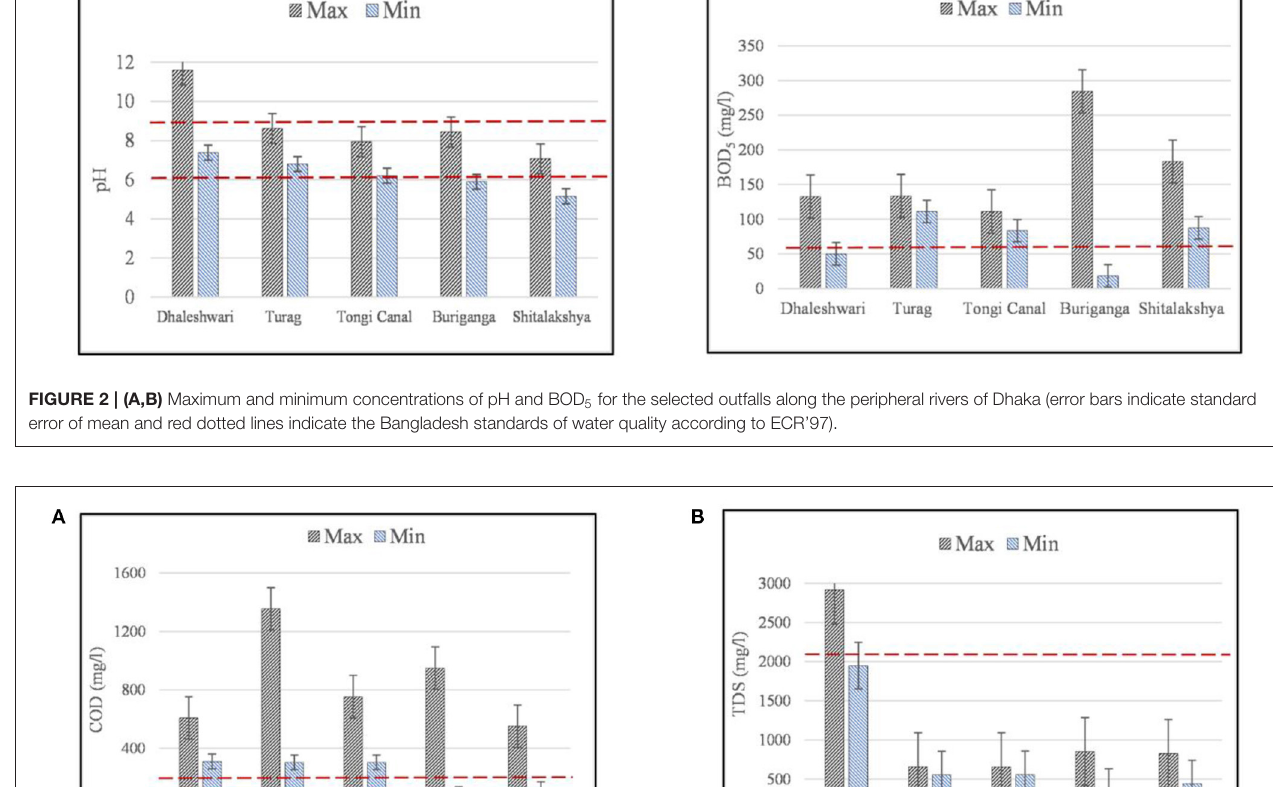
Minerals, alkalis, certain colloidal and dissolved solids in water, some acids, sulfates, metallic ions, etc., are all included in the total dissolved solids (TDS) category (49). TDS levels in the